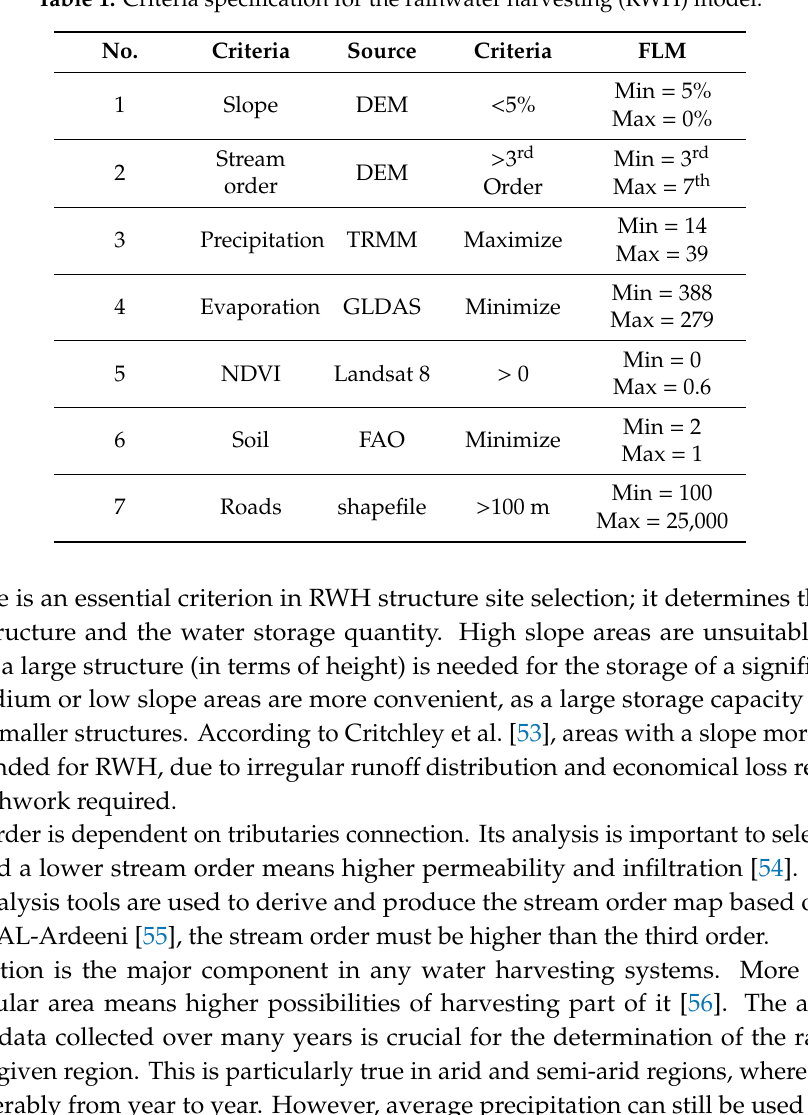
Table 1. Criteria specification for the rainwater harvesting (RWH)